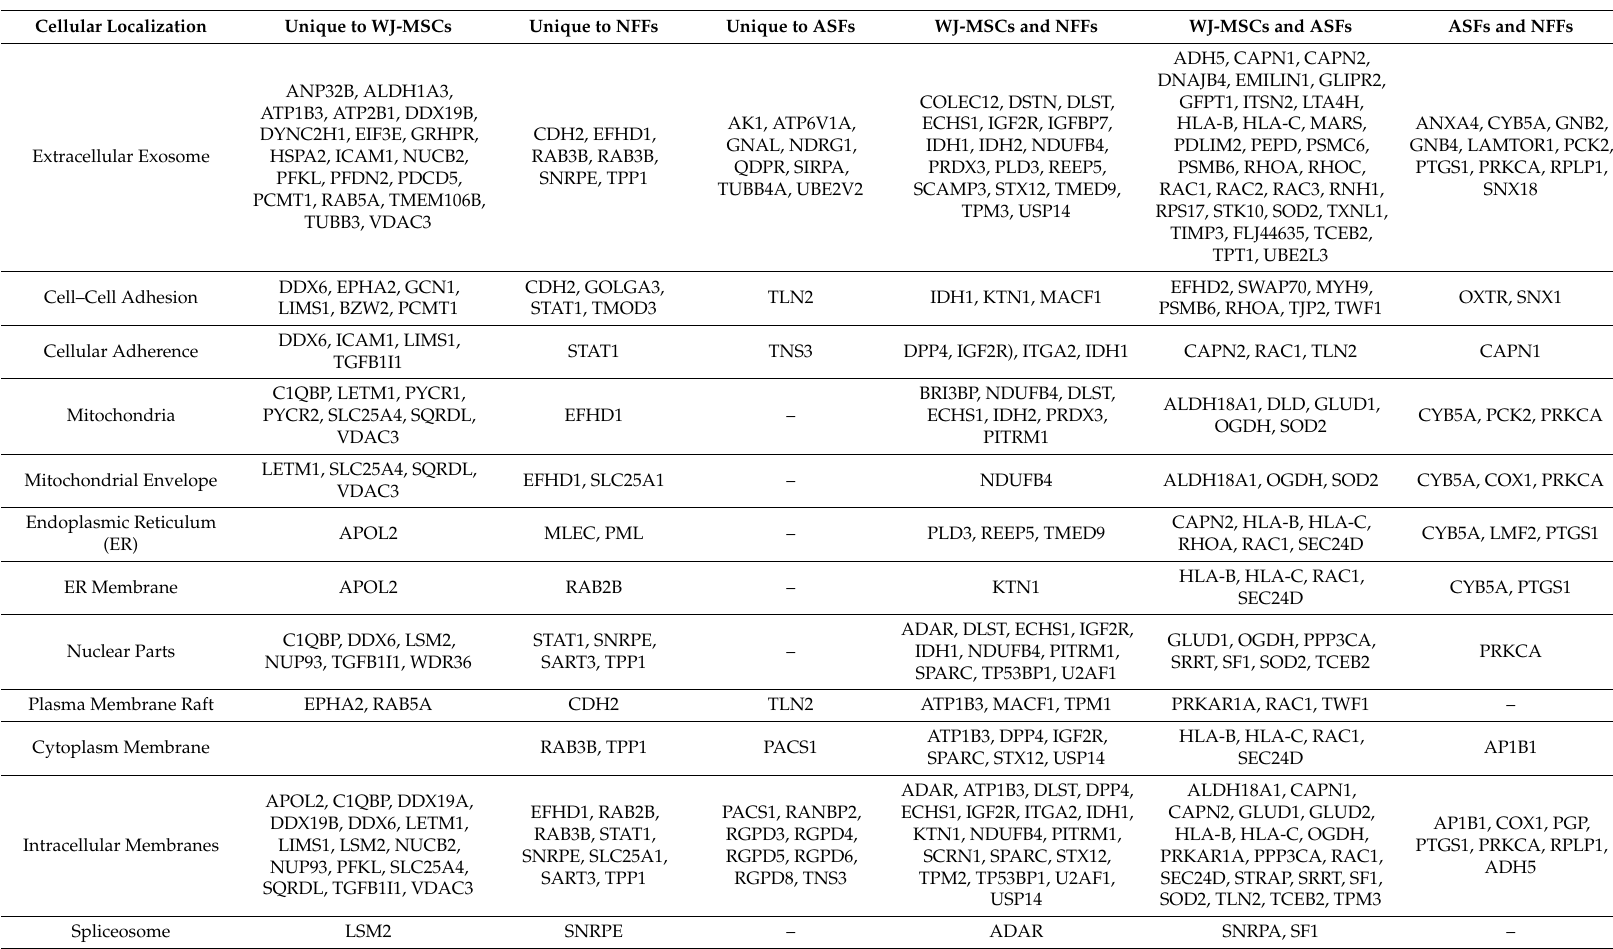
Table 1. Cellular localization of the membrane-bound proteins di ff erentially expressed by WJ-MSCs, ASFs, and NFFs. − means